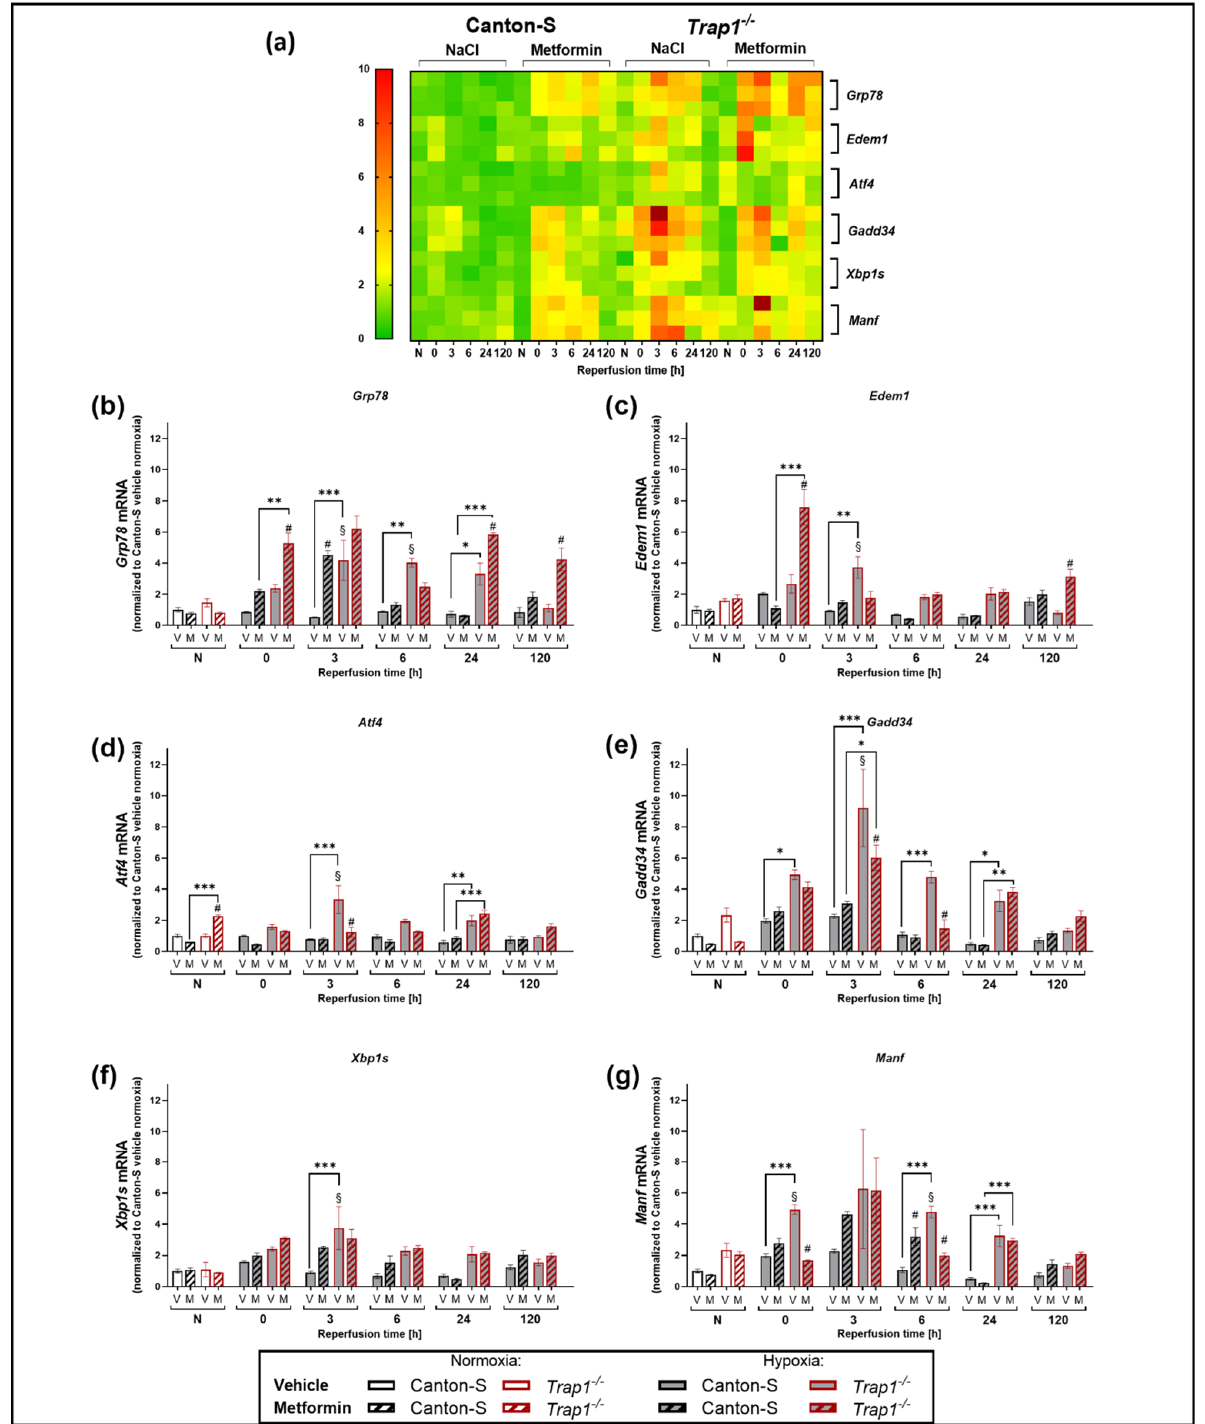
Figure 6. Post-hypoxic mRNA levels of proteins involved in the UPR pathway in Canton-S and Trap1 − / − D. melanogaster after exposure to 3 h of hypoxia. ( a ) Heatmap displaying the mRNA levels of Grp78, Edem1, Atf4, Gadd34, Xbp1s, and Manf in Canton-S and Trap1 − / − at different post-hypoxic reperfusion timepoints (0, 3, 6, 24, and 120 h after hypoxia) as a summary of the results of ( b – g ). Target genes are presented as ratios to the constitutive gene eEF1 α 1 and normalized to the vehicle Canton-S normoxia. ( b–e ) Graphs showing the mRNA expression levels of UPR markers. Target genes are presented as ratios to the constitutive gene eEF1 α 1 and normalized to the vehicle Canton-S normoxia. V: vehicle (NaCl) and M: Metformin. Statistics: Two-way ANOVA followed by Tukey post-hoc. * p < 0.05., ** p < 0.01, *** p < 0.001. # p < 0.05 indicates significance compared to the corresponding vehicle. § p < 0.05 indicates significance compared to corresponding normoxia.